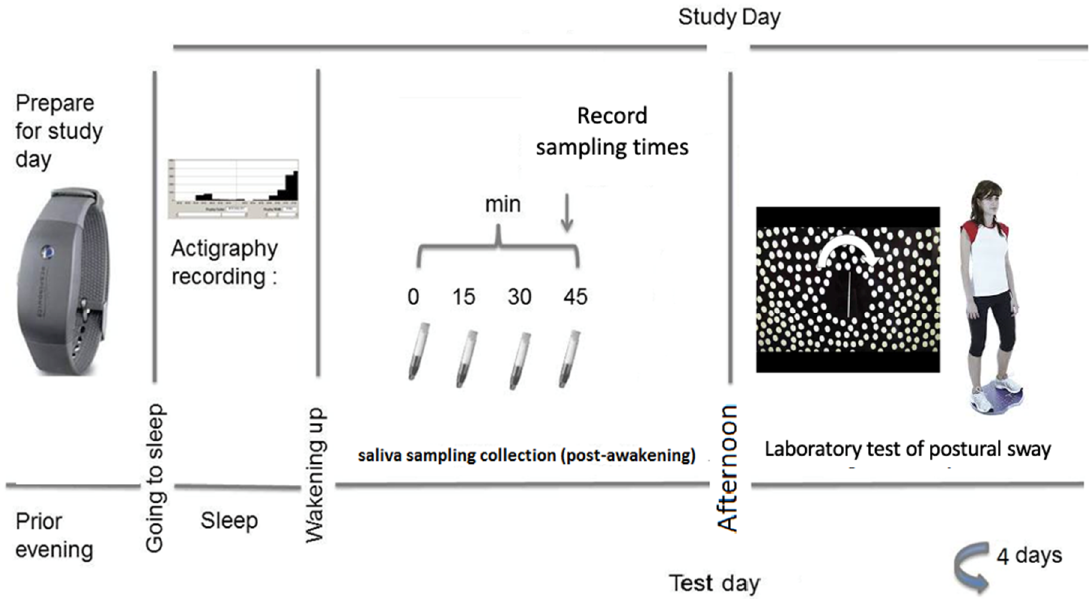
Figure 1. Timeline of protocol for measurement of the CAR and postural sway.